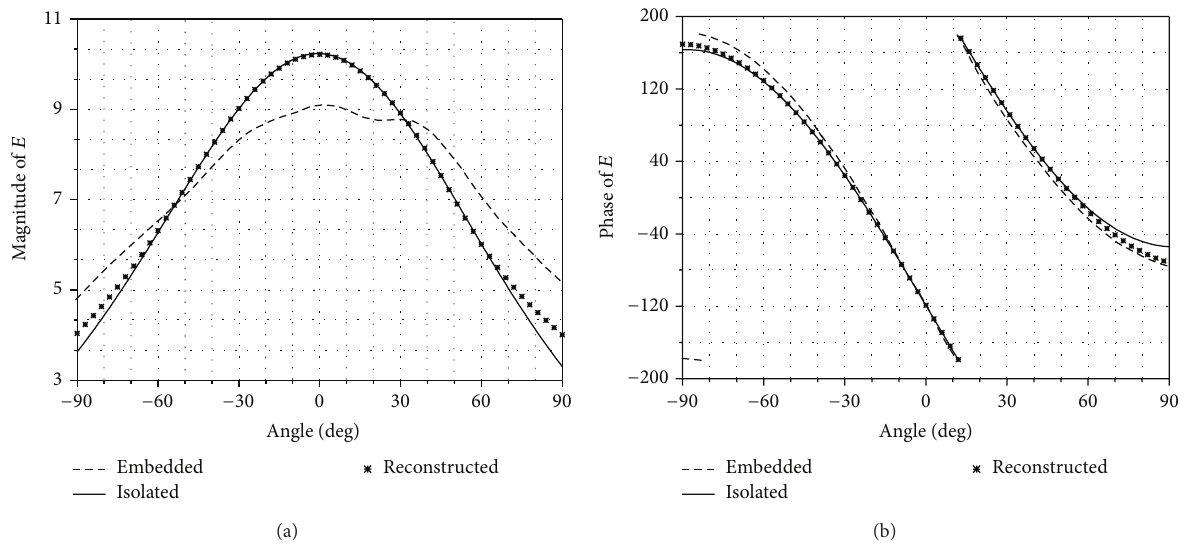
Figure 7: Magnitude and phase of 𝜃 component of the electric field in three cases for the circularly polarized microstrip array.